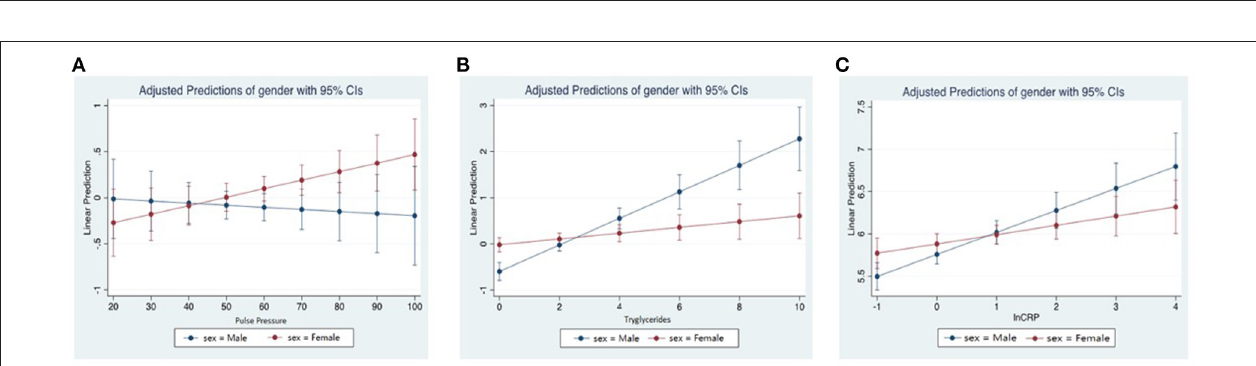
FIGURE 3 | (A) Linear predictions of standardized natural log fibroblast growth factor 21 (lnFGF21) with pulse pressure by sex. (B) Linear predictions of lnFGF21 with triglycerides by sex. (C) Linear predictions of lnFGF21 with lnCRP by sex.